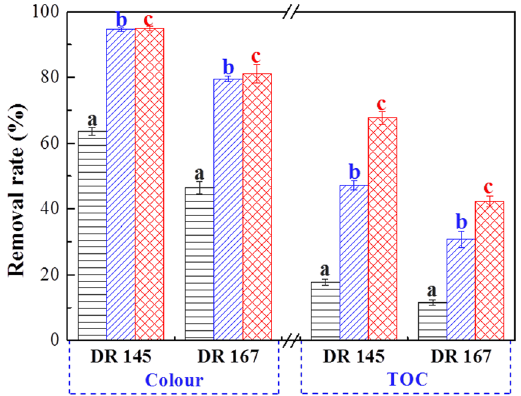
Figure 2. Decolourization and TOC removal of dispersed dye-production wastewater by ( a ) PAC coagulation, ( b ) the one-step process of organobentonite and ( c ) the one-step process with PAC. Bentonite dose: 0.5 g L − 1 ,